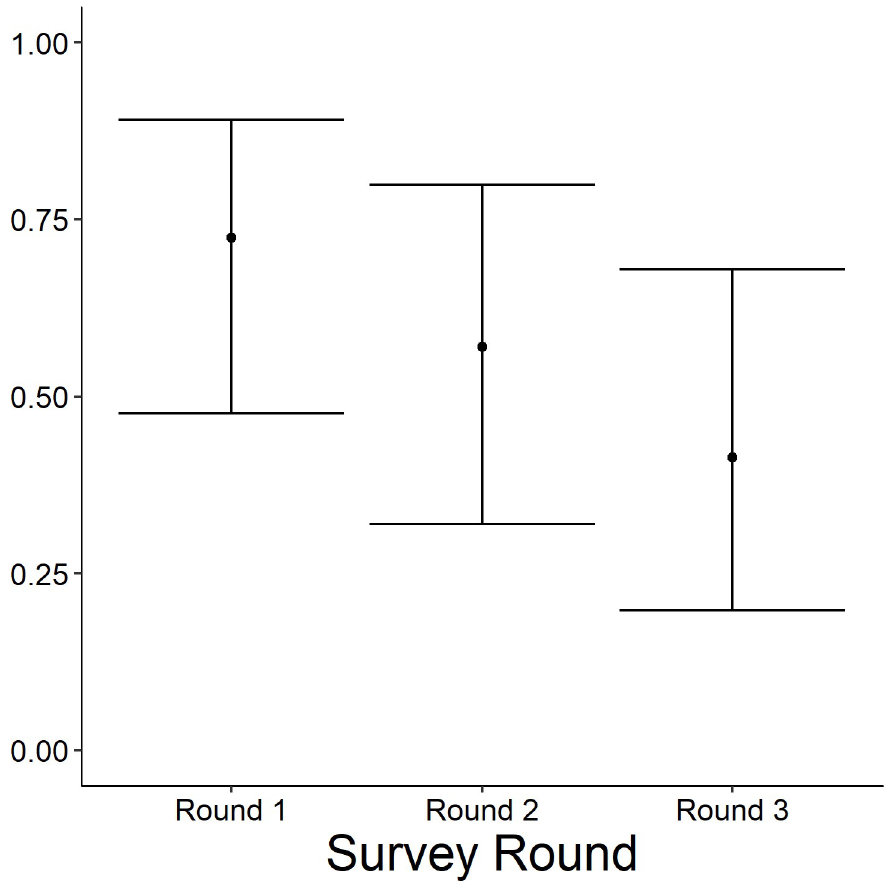
Fig 6. Predicted probability (95% confidence limits) of site occupancy for the emergent marsh bird group (American bittern, Botaurus lentiginosus ; least bittern, Ixobrychus exilis ; sora, Porzana Carolina ; king rail, Rallus elegans ; virginia rail Rallus limicola , and yellow rail, Coturnicops noveboracensis ) across survey rounds in Illinois during late spring and early summer 2015–2017.